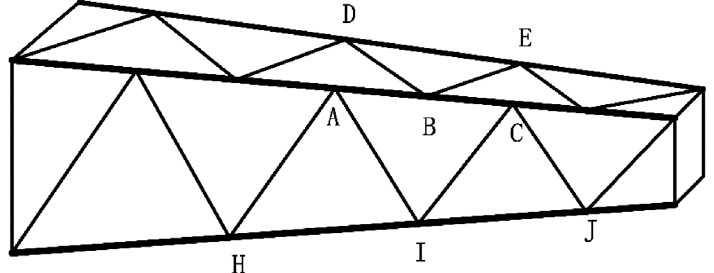
Fig. 1. Cross-type truss boom with variable cross-section web member.